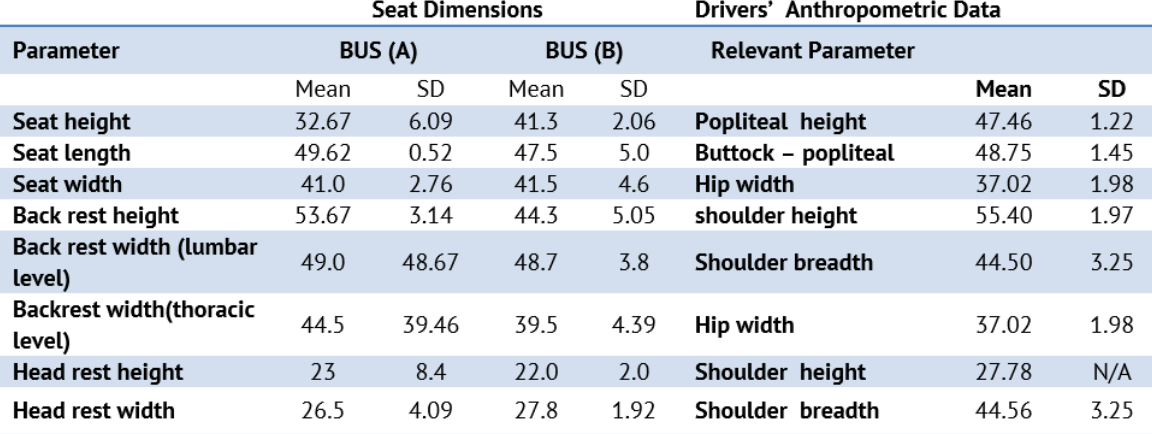
Analysis of Seat Dimensions and Relevant Drivers’ Anthropometric Dimensions in this Study